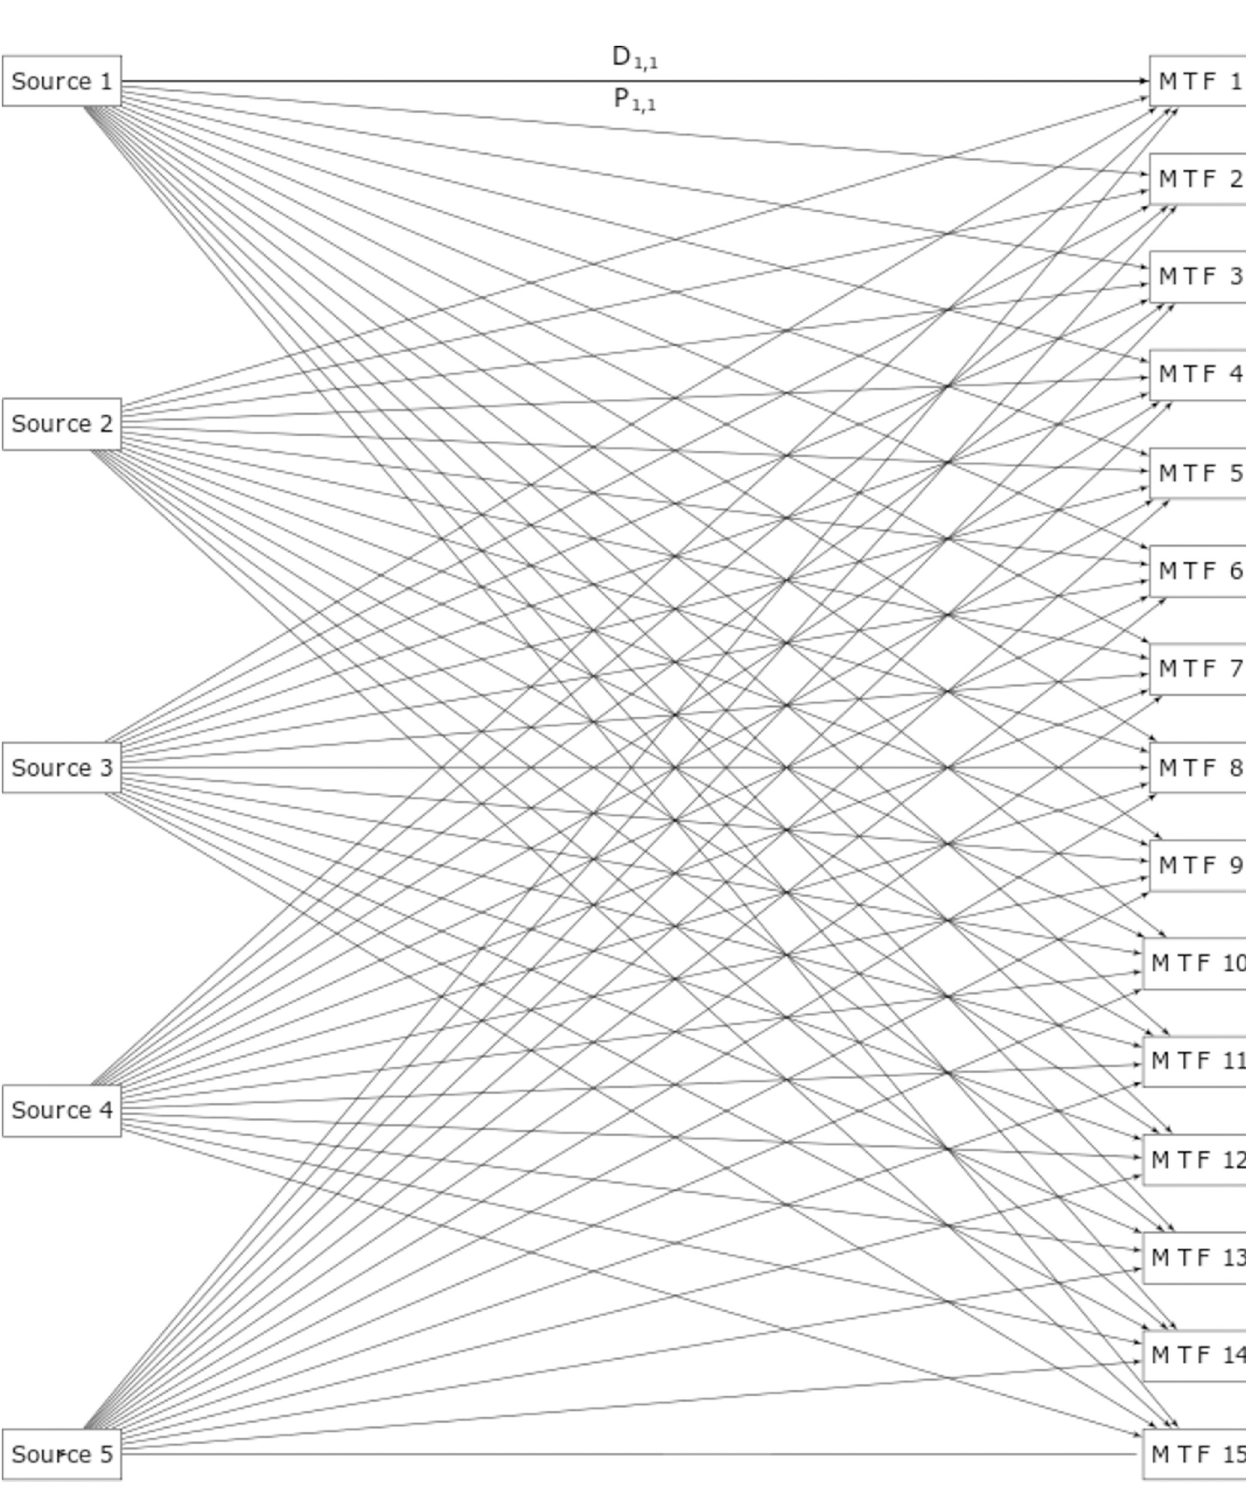
PLOS ONE | https://doi.org/10.1371/journal.pone.0222023 September 11,